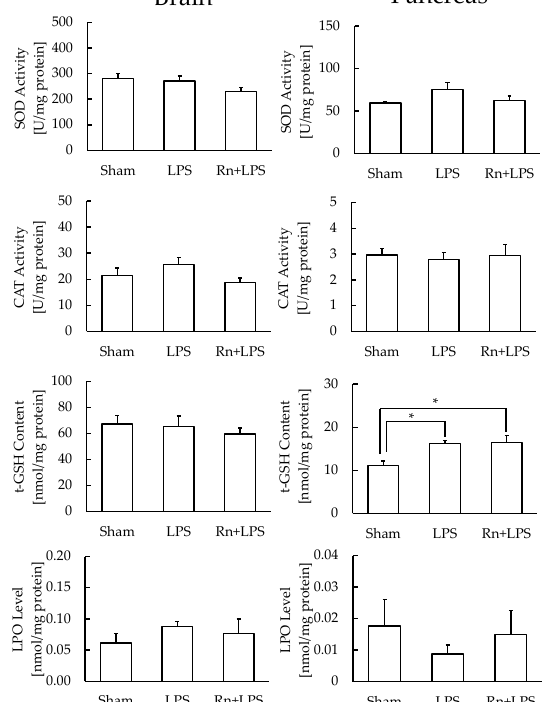
Figure 4. Effect of radon (Rn) inhalation on oxidative stress associated with lipopolysaccharide (LPS) administration in the brain and pancreas. The results are presented as the mean ± SEM. N = 7; * p < 0.05; all experiments were conducted once; * p < 0.05; sham, mouse group without any treatment; sham + LPS, mouse group that inhaled sham followed by LPS (1 mg/kg body weight); Rn + LPS, mouse group that inhaled radon (2000 Bq/m 3 ) followed by LPS (1 mg/kg body weight); SOD, superoxide dismutase; CAT, catalase; GSH, glutathione; LPO, lipid peroxide. In lungs with low antioxidant function and high LPO levels, CAT activity signifi- cantly increased in the sham + LPS group compared to the sham group, and LPO levels significantly increased with or without radon inhalation compared to that of the no treat- ment control. However, the levels of LPO and CAT did not differ between sham + LPS and Rn + LPS groups (Figure 5). In large intestines with similar conditions, radon inhala- tion significantly suppressed the LPS-induced increase in SOD activity. No significant changes were observed in the levels of the oxidative stress markers among the three groups in hearts or small intestines with similar antioxidant functions (Figure 5).